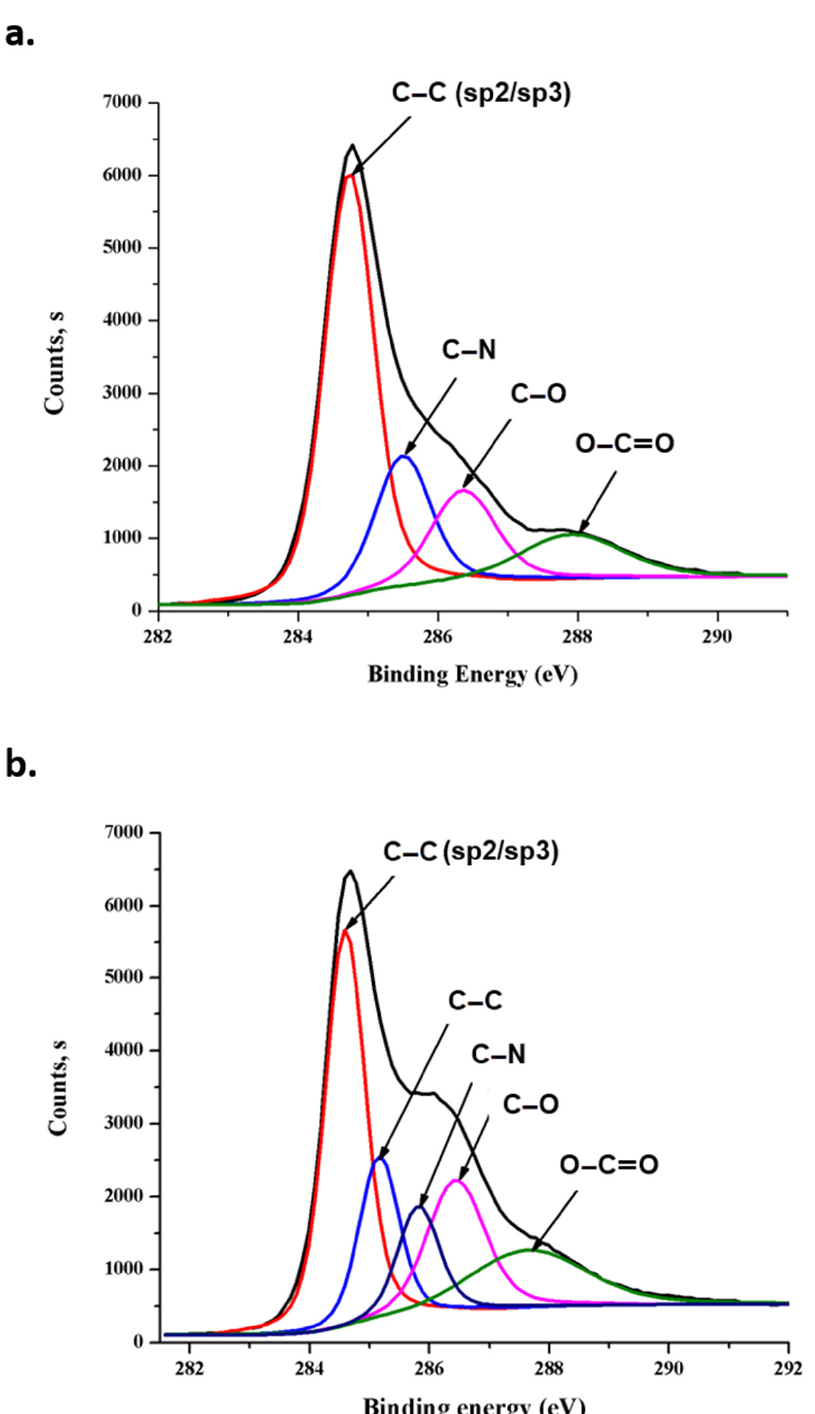
Figure 4. C 1s high resolution XPS spectra of rGO-NH 2 before ( a ) and after functionalization ( b ) with CE.